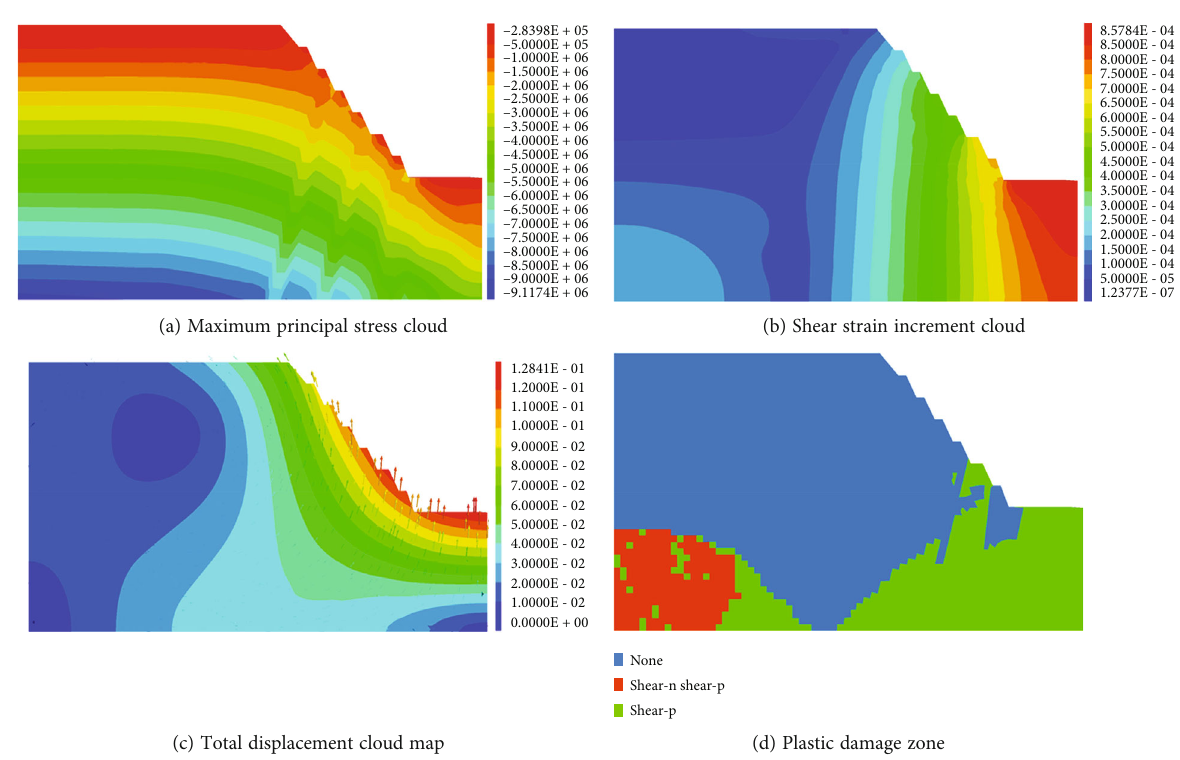
Figure 8: Excavation stage